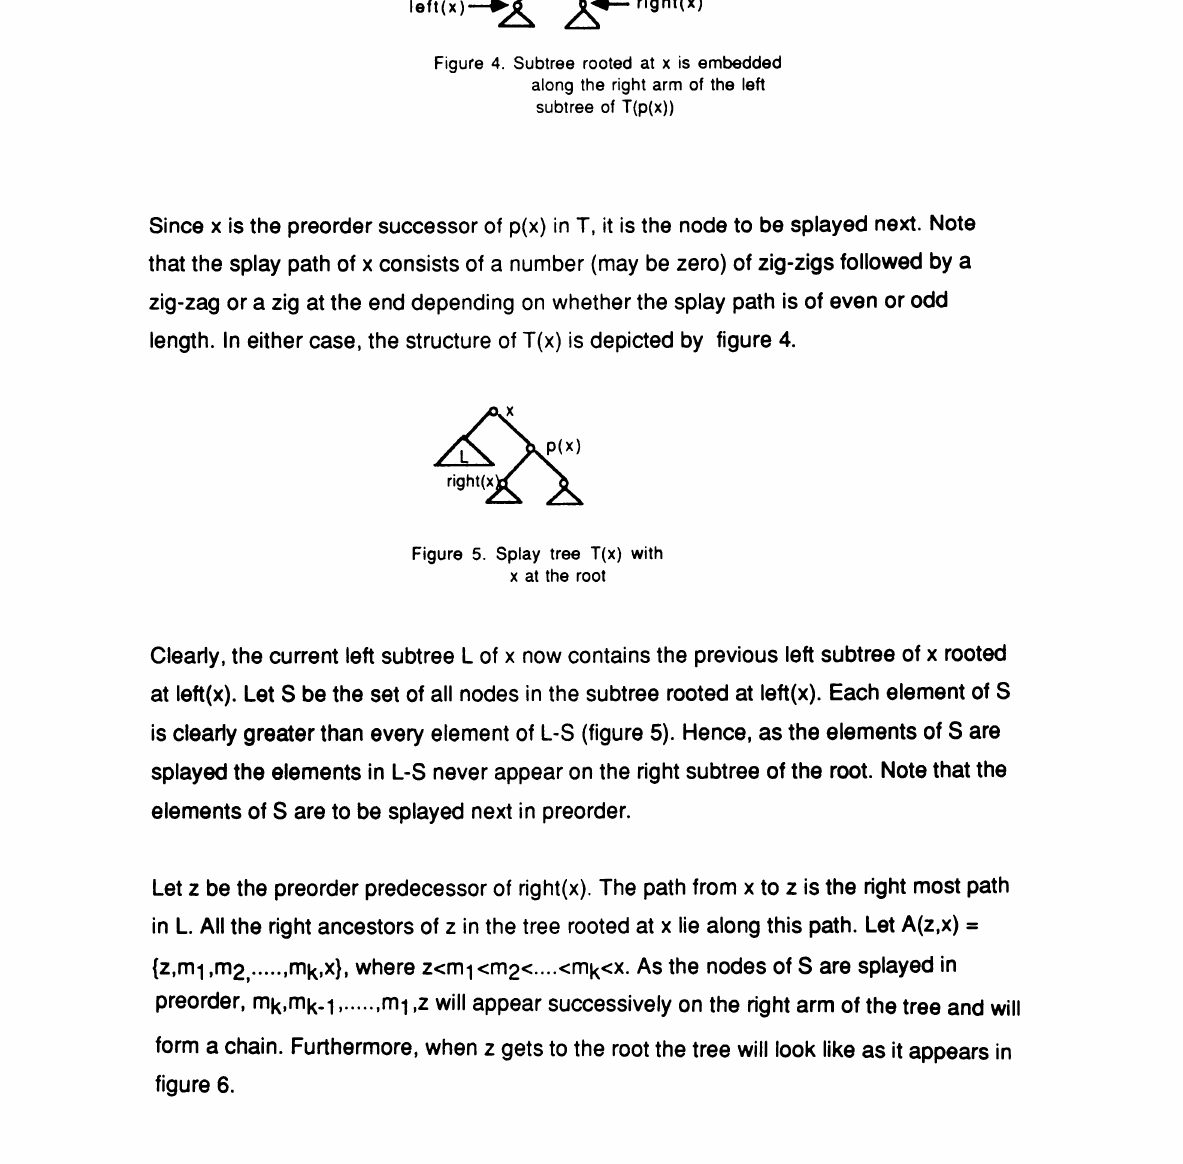
Figure 4. Subtree rooted at x is embedded along the right arm of the left subtree of T(p(x))